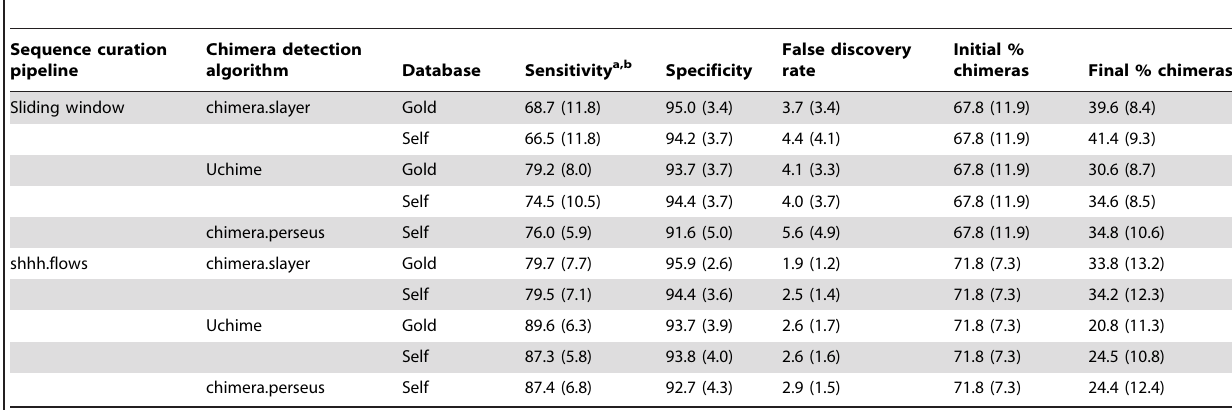
Table 1. Ability of chimera.slayer, Uchime, and chimera.perseus to detect reliably chimeras within the sliding window and shhh.flows pipelines when using the Gold sequence collection or the dataset itself as the reference.